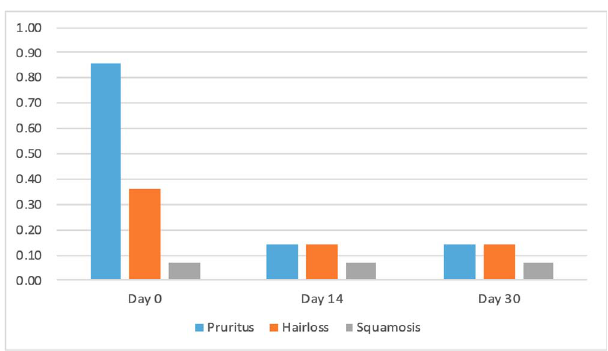
Figure 8. Average score for clinical signs associated with lice in cats from Group 1 (NexGard Combo (cid:1) ).